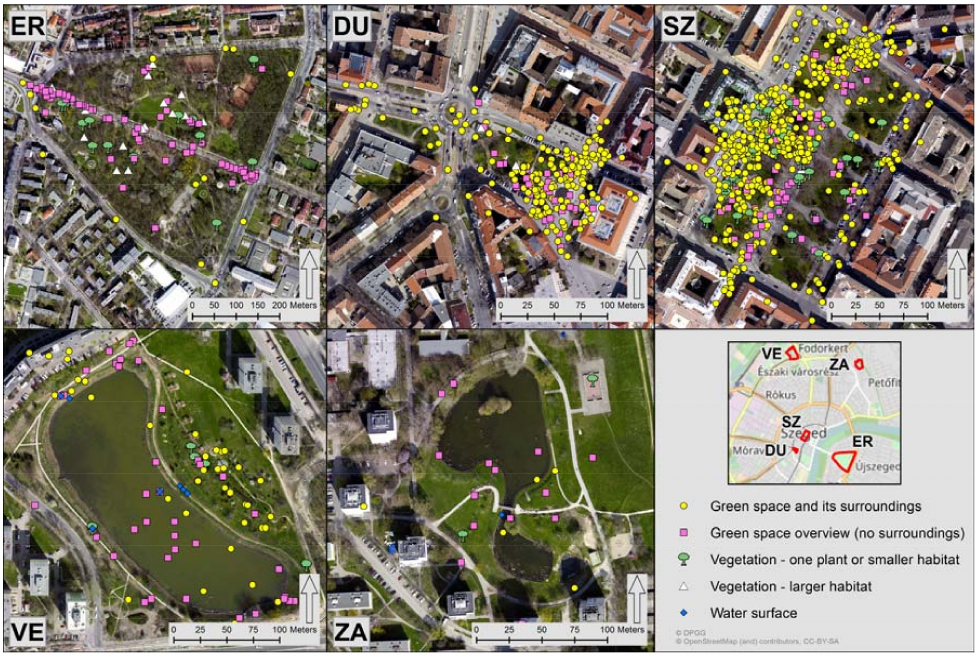
Figure 3. Distribution of images picturing green space aesthetics. ER: Erzs é bet liget; DU: Dugonics t é r; SZ: Sz é chenyi t é r; VE: V é r-t ó ; ZA: Z á por-t ó . Figure created by the authors. Sources of base